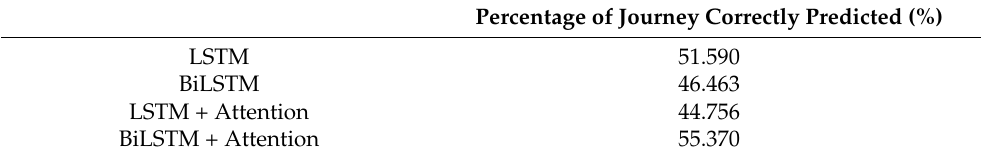
Table 7. Percent of journey correctly predicted for all models tested against the unseen journey to Destination